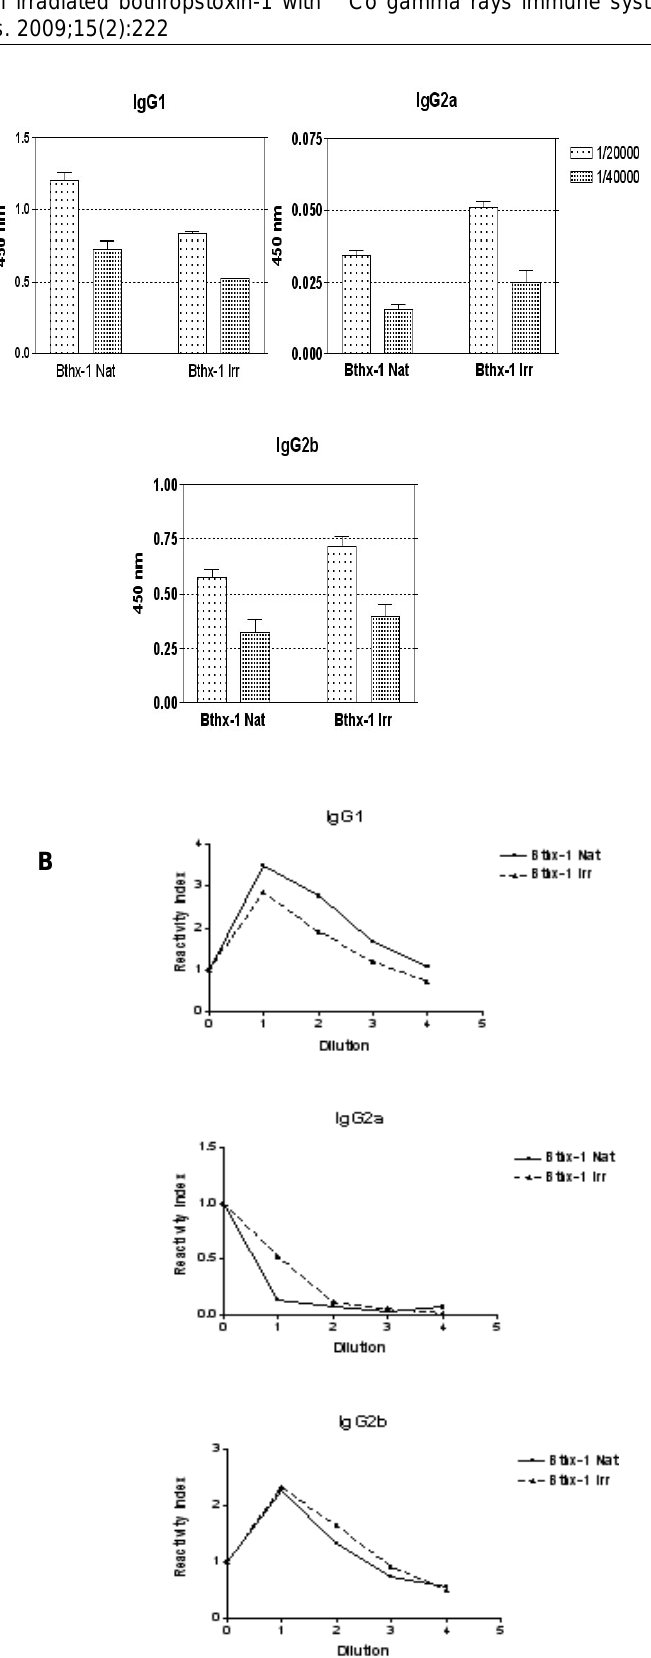
Figure 3. ELISA for antibody isotyping (IgG1, IgG2a and IgG2b) in native (Nat) and irradiated (Irr) bothropstoxin-1 samples ( A ). Reactivity index of ELISA ( B